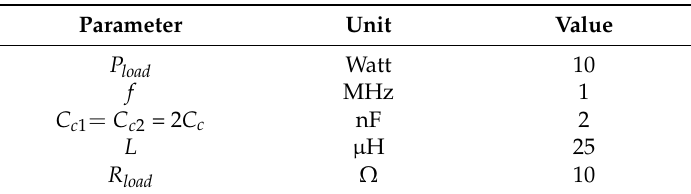
Table 1. Parameters used for